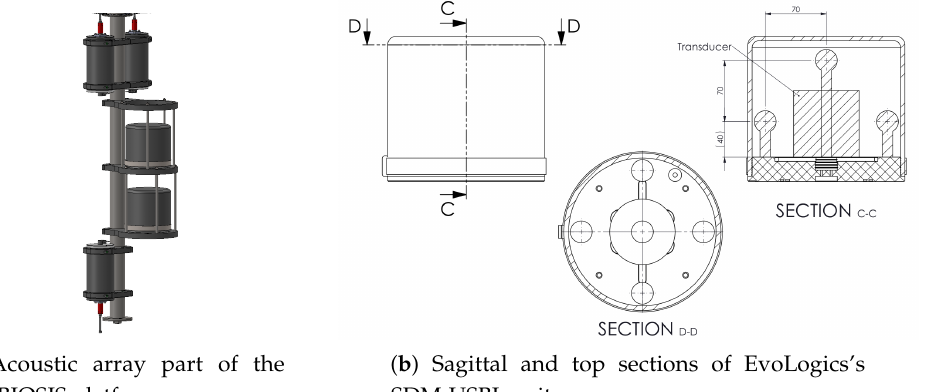
Figure 6. ( a ) rendering of part of the upper portion of SYMBIOSIS platform, showing the acoustic array of opportunity employed in our experiment (two cylindrical SDM-USBL units, facing right); ( b ) internal configuration of an SDM-USBL unit. Each sphere denotes a receiving acoustic element (5 in total, arranged into a pentahedral, square-base pyramid). The unit includes a transducer (the large cylindrical element in the sagittal C-C section), not used in our setting.